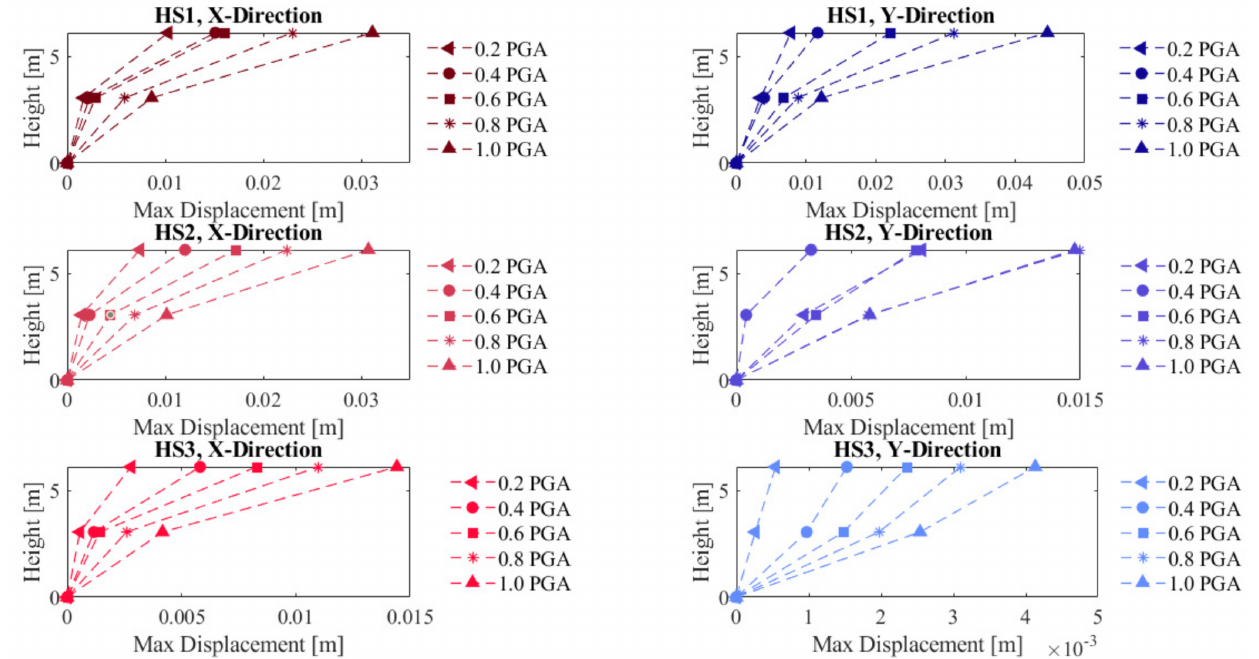
Figure 18. Mean drifts values under different earthquake multiplication factors for the two main directions, at varying the floor